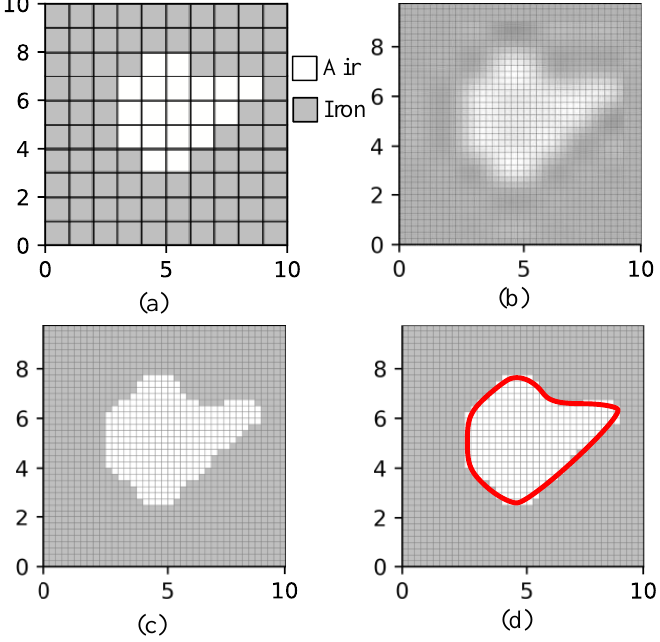
Figure 6. The overall process of high-resolution interpolation and edge smoothing method. ( a ) is binary encoded topology (10 × 10) for genetic algorithm, ( b ) is interpolated bitmap topology (50 × 50), ( c ) is smoothed edge based on using suitable density threshold, i.e., 0.5 in this figure, and ( d ) is the vectorized boundary (closed curve in red) for FE model.